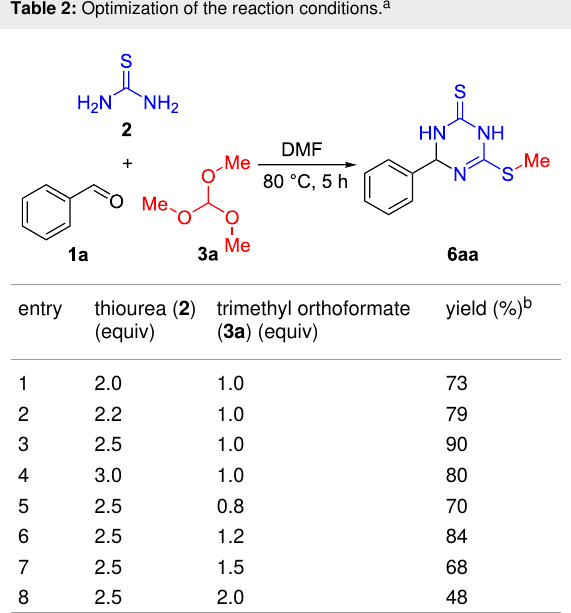
Table 2: Optimization of the reaction conditions.